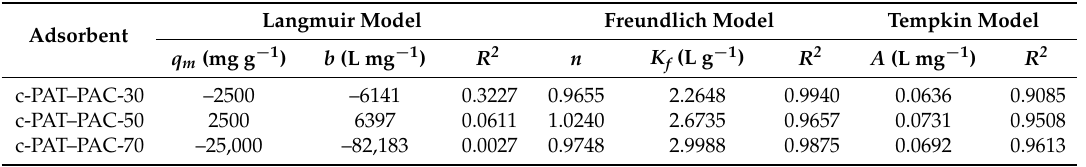
Table 4. Freundlich isotherm model and Tempkin isotherm model constants and correlation coefficients for Ni(II) adsorption onto PAT–PAC